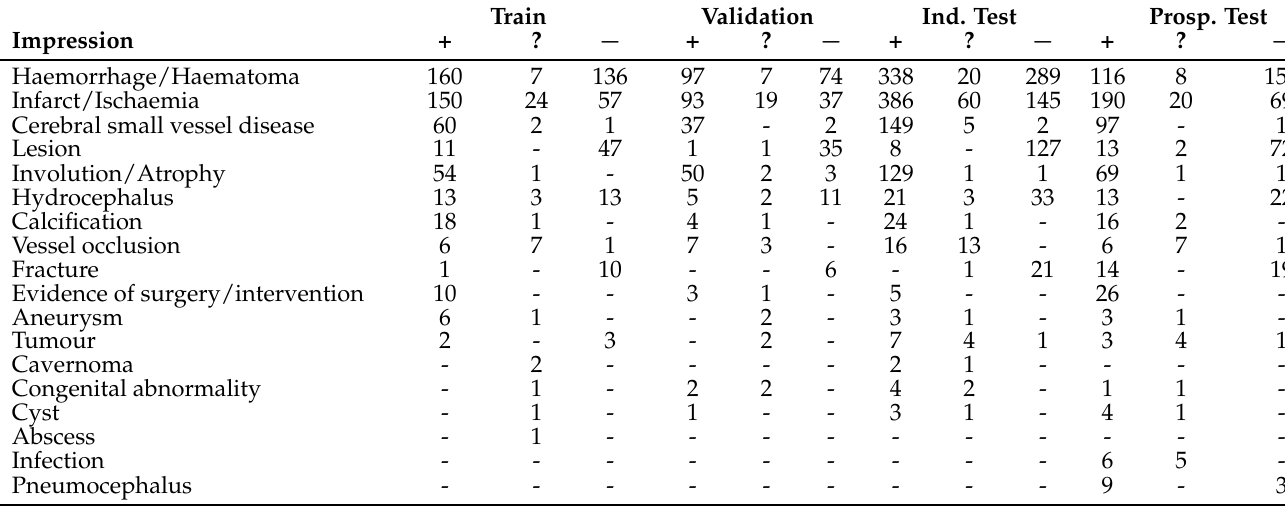
Table A3. Counts for our clinical impression labels in each of our data subsets: training, validation, independent test and prospective test. “+” represents a positive mention, “?” represents an uncertain mention and “ − ” represents a negative mention. In the table body, a “-” represents 0